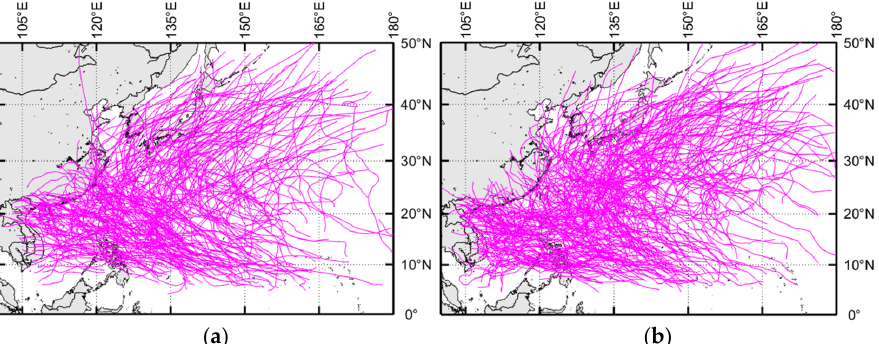
Figure 9. Illustration of the TC tracks for a period of 10 years: ( a ) Using historical TC tracks from 2001 to 2010 based on the historical catalogue given in Ying et al. (2014) and ( b ) Using synthetic TC tracks generated by applying the model given in Li and Hong (2016) for a period of 10 years.